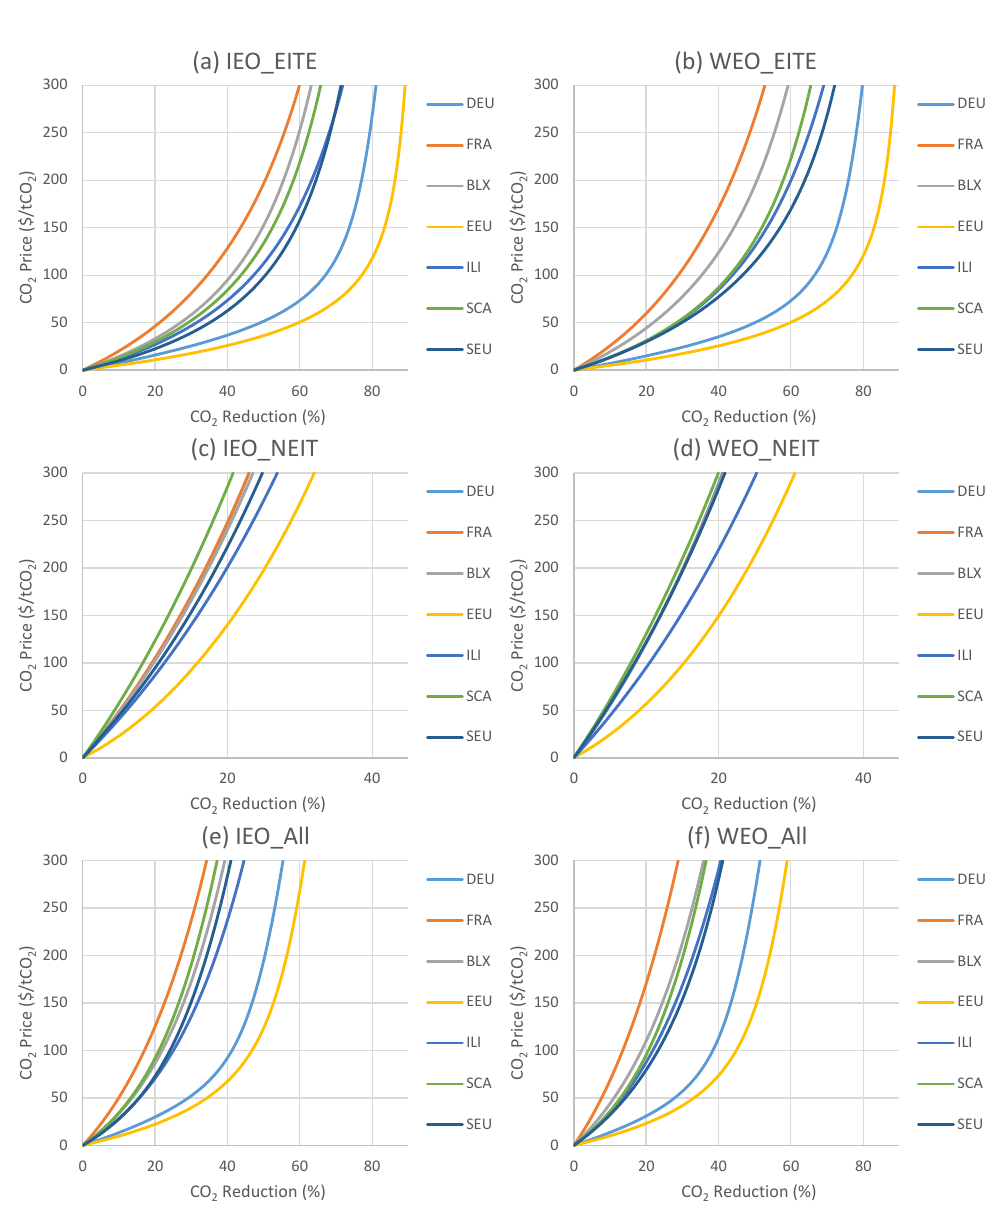
Figure 4. EITE, NEIT, and ALL MACCs in percentage change for different European regions in 2030 under the IEO and WEO baselines.